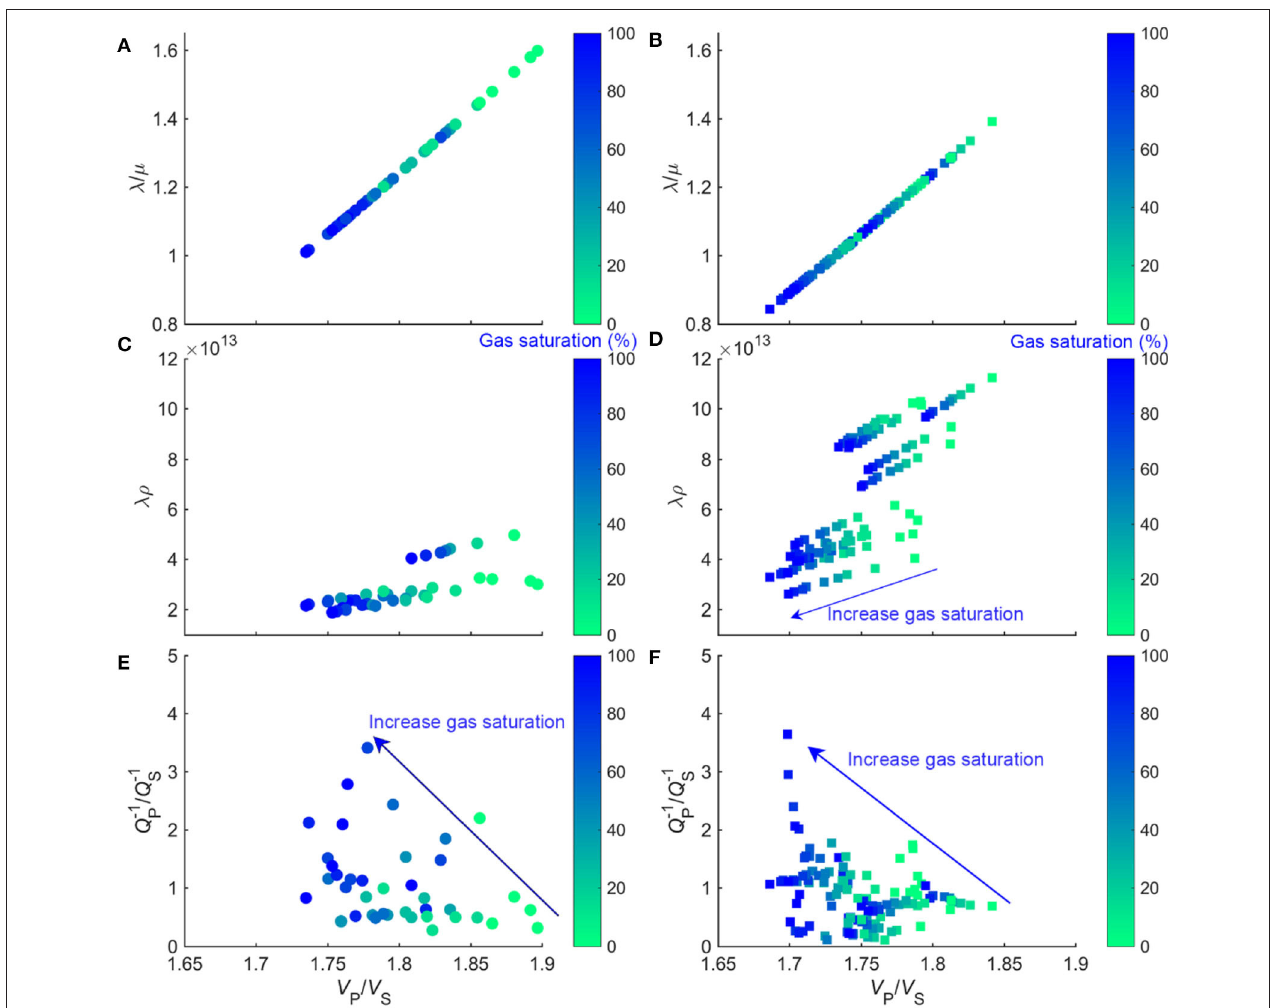
FIGURE 6 | Crossplots of λ/µ – V P / V S , λρ – V P / V S , and Q − 1 P / Q − 1 S – V P / V S for siltstones (A,C,E) and dolomites (B,D,F) at partial gas–water saturation. The color from green to blue denotes gas saturation increasing from 0 to 100%.